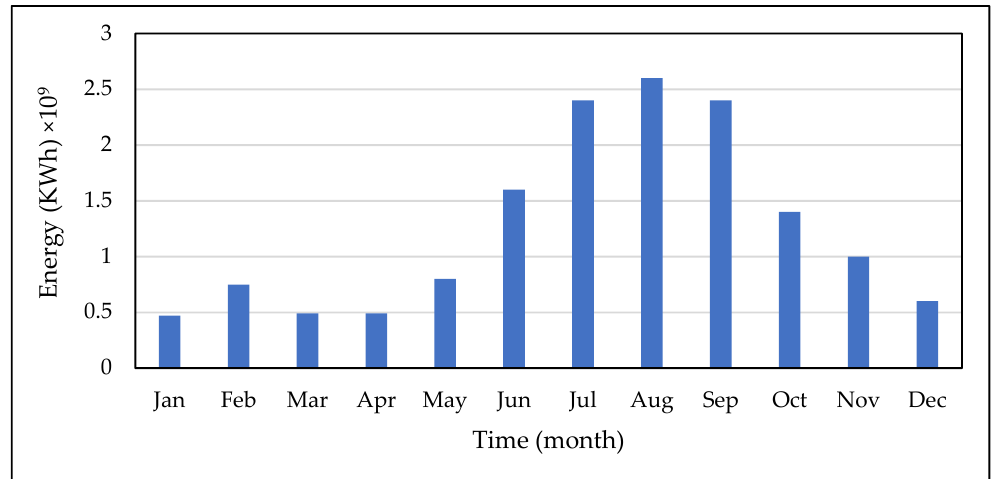
Figure 10. Mean Monthly Power generation pattern of Tarbela Reservoir (2008–2020).